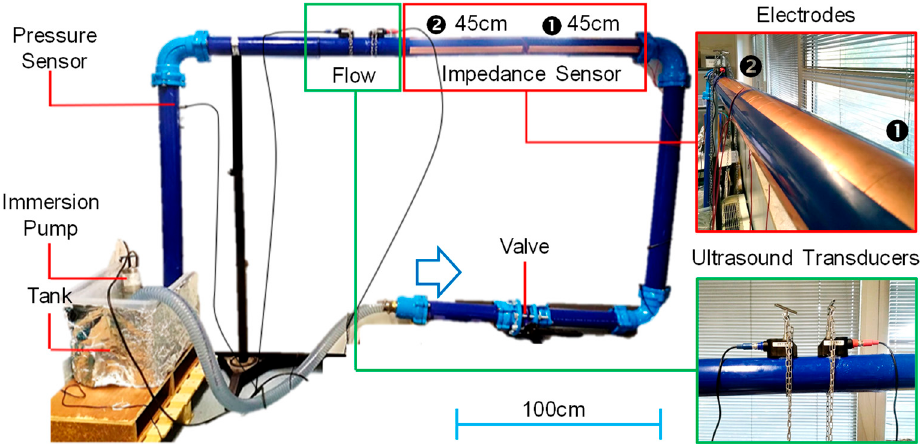
Figure 4. Hydraulic loop realized for the experimental validation of the contactless sensors at real- istic water speed. water